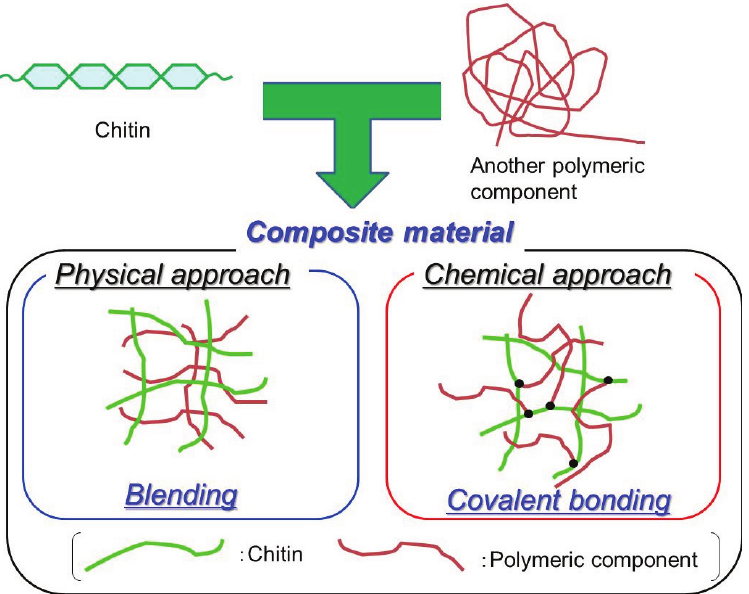
Figure 9. Physical and chemical approaches for fabrication of composite materials of chitin with another polymeric component.